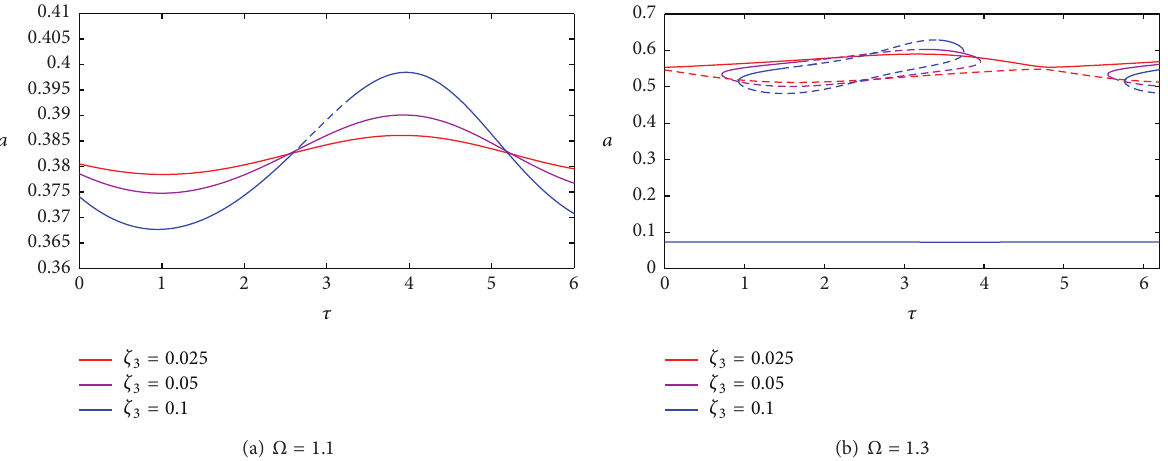
Figure12:Effectofthetimedelay 𝜏 onthestabilityofvibrationamplitudeforthecontrolledsystemwithdifferentfeedbackgain 𝜁 3 ( 𝜁 1 = 0.025 , = 0.05 , 𝑘 = 1 , and ̂𝜆 = 0.4 𝑓 1